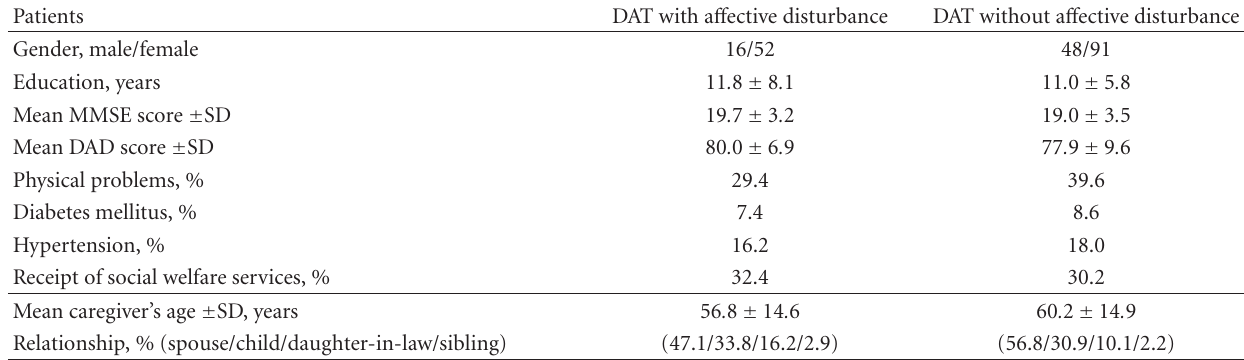
Table 4: Comparison of demographic, disease-related, and caregiver-related variables of DAT patients with and without a ff ective disturbance at the time of